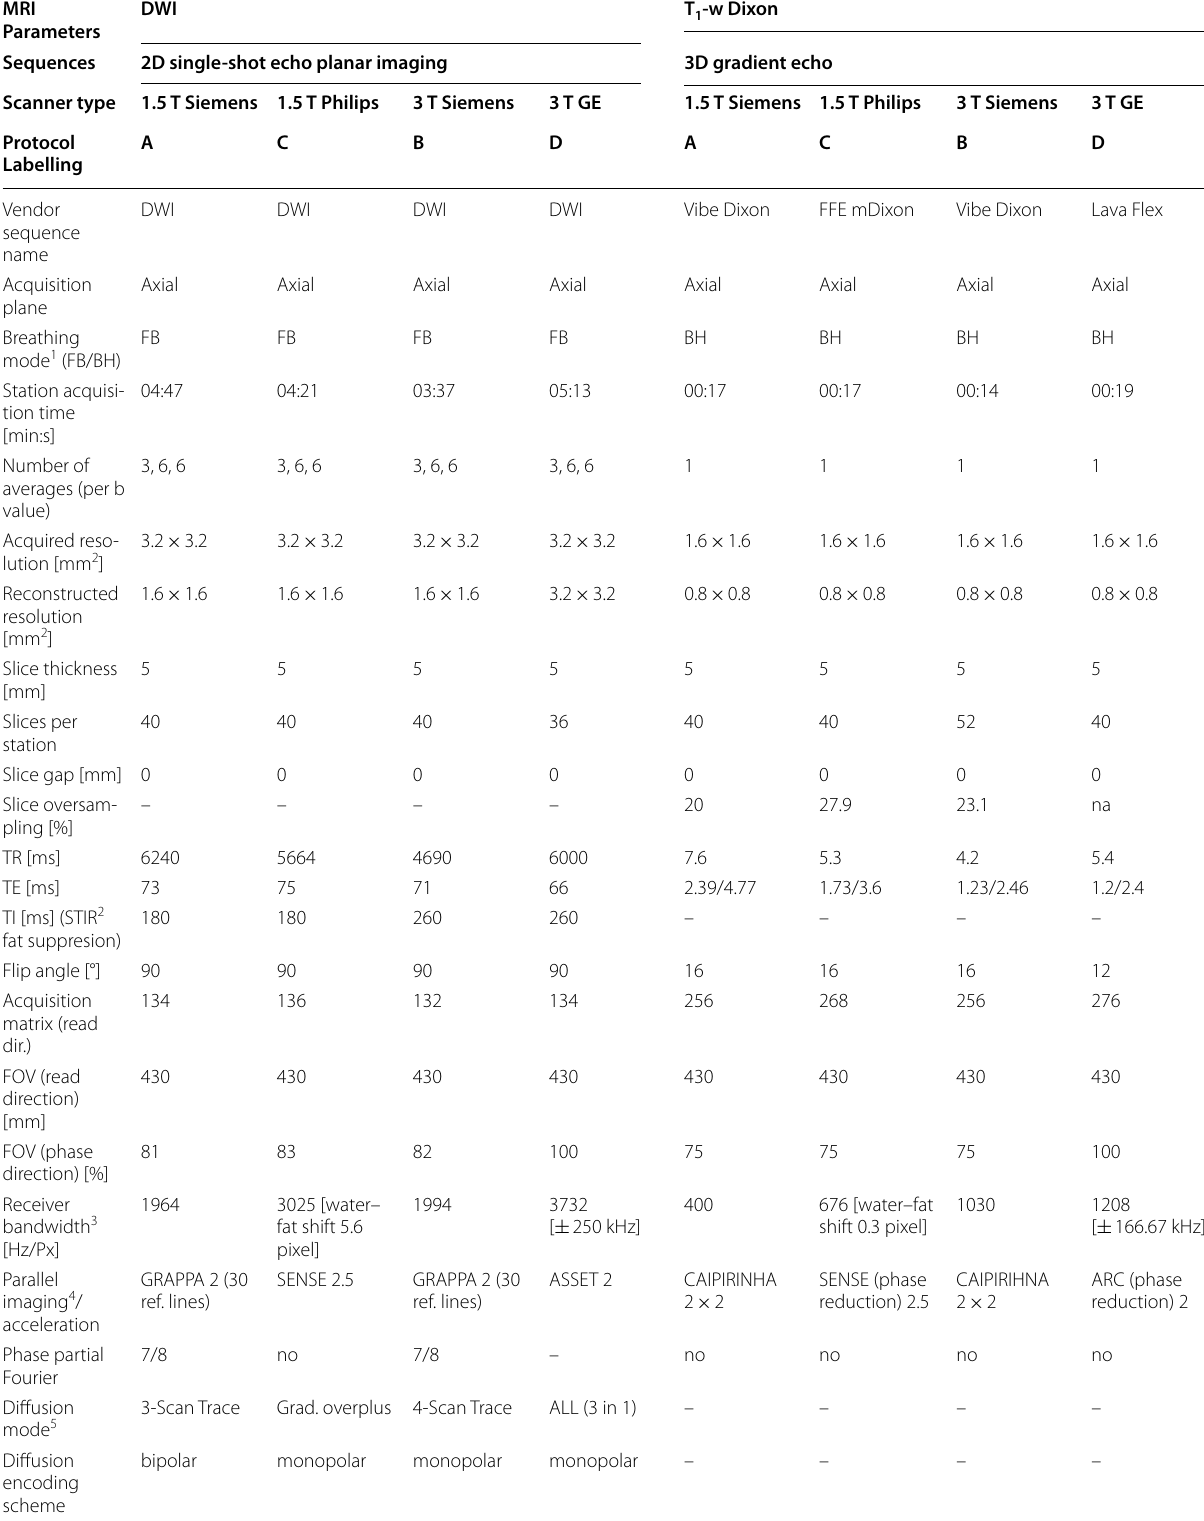
Table 2 WB‑MRI protocol (DWI and T ‑w Dixon) for four main scanners across the 12 sites 1 MRI DWI T 1 -w Dixon Parameters Sequences 2D single-shot echo planar